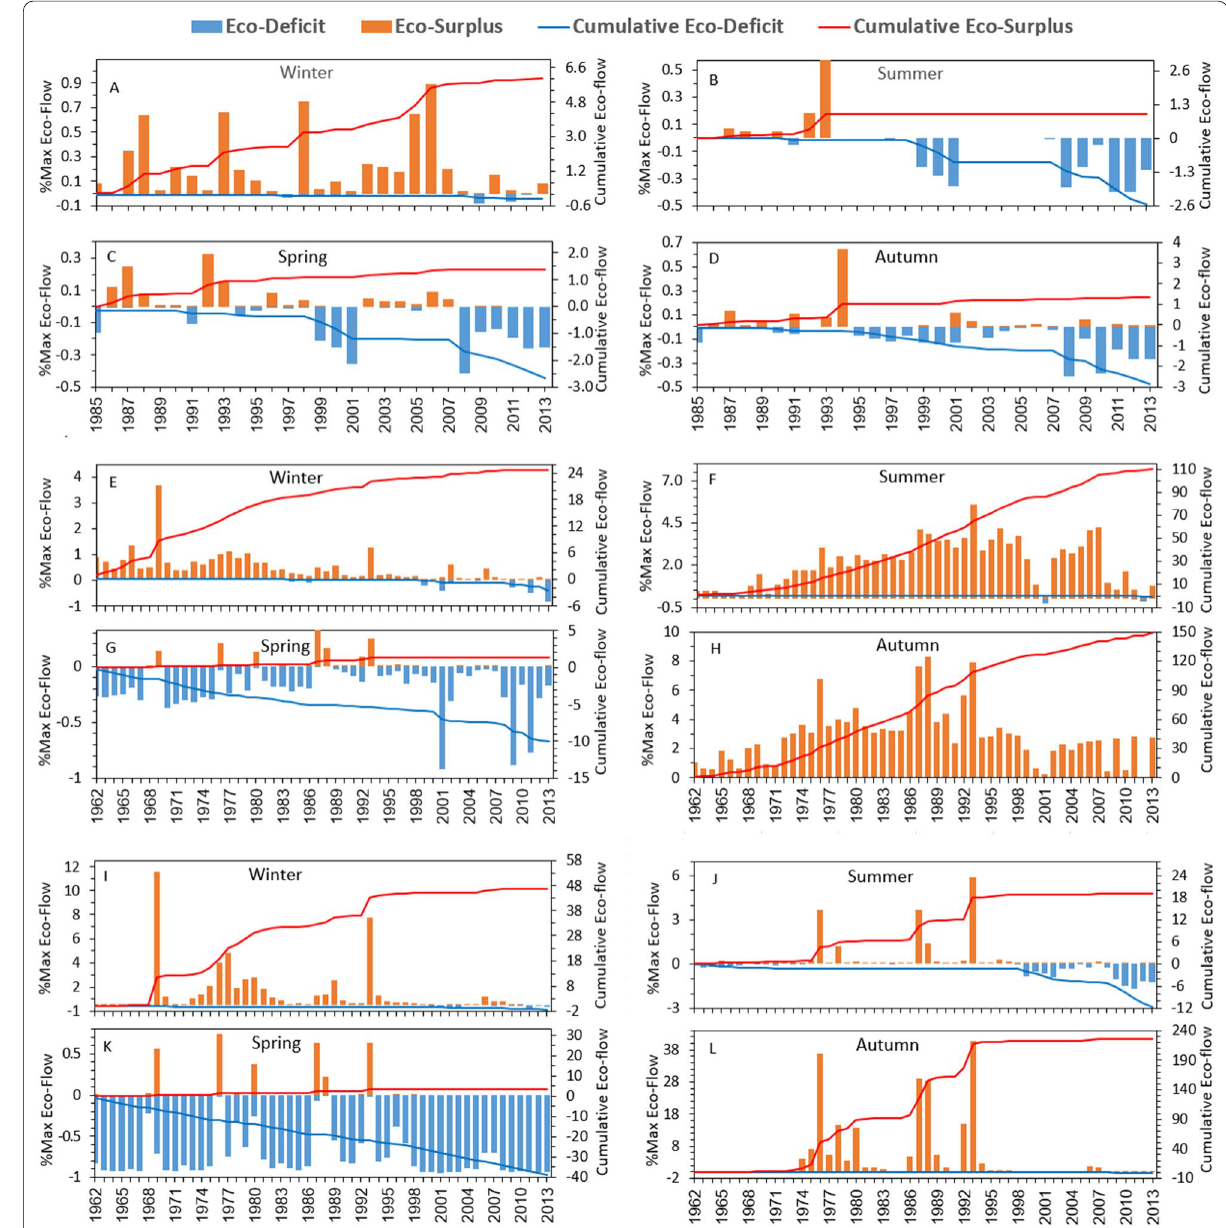
Fig. 5 The seasonal and cumulative eco-deficit and eco-surplus conditions in response to flow exceedance probability at ( A – D ) Qale-Shahrokh, ( E – H ) Pole-Kalle, and ( I – L ) Varzanah stations during spring, autumn, winter, and